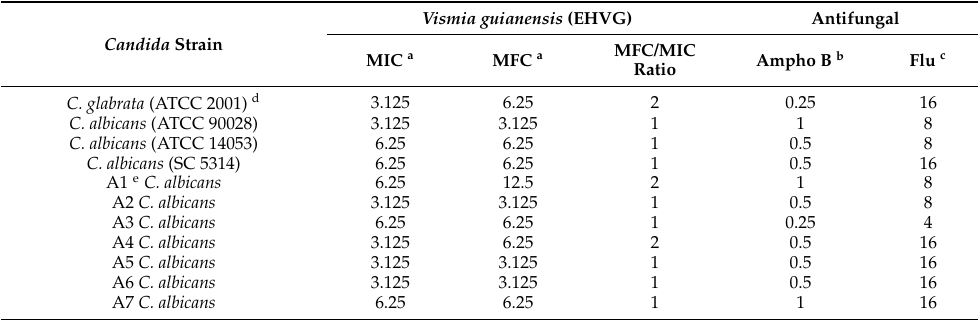
Table 3. Minimum inhibitory (MIC) and minimum fungicidal (MFC) concentrations of the hydroalco- holic leaf extract of Vismia guianensis (EHVG) against Candida spp. strains. Candida Strain